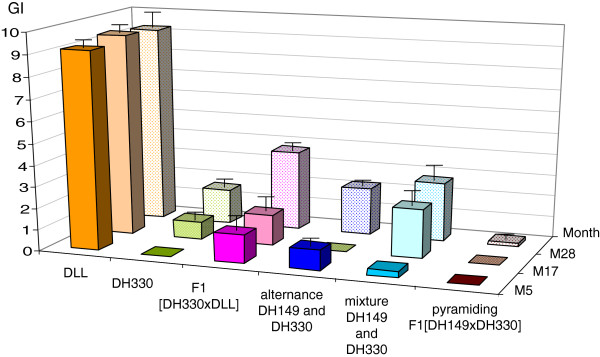
Gall index (GI) on peppers (mean of 40 to 45 replicates ± standard error) over the 3-years field experiment. GI checked at five (M5), 17 (M17) and 28 (M28) months. For mixture of R-genes, the reported value is the mean GI on DH149, no gall being observed on DH330. DLL was the susceptible cultivar as control, DH149 is homozygous resistant Me3/Me3, DH330 is homozygous resistant Me1/Me1.